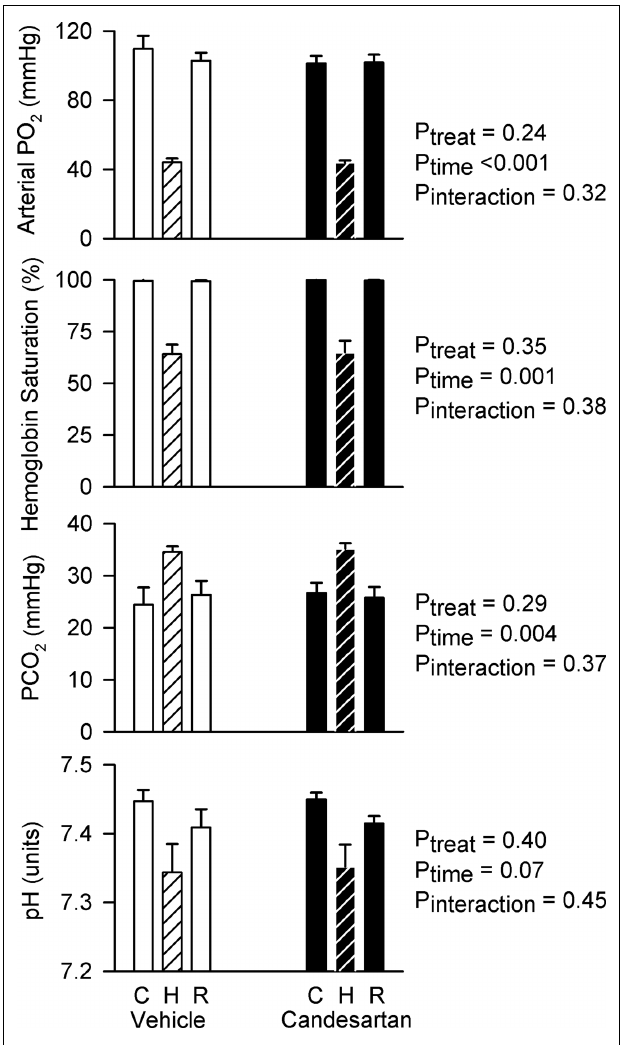
FIGURE 1 |Arterial blood gases before, during and after hypoxia in conscious rabbits treated with candesartan or its vehicle. PO 2 , the partial pressure of oxygen; PCO 2 , the partial pressure of carbon dioxide; C, control; H, hypoxia; R, recovery. P values represent the outcomes of two-way repeated measures analysis of variance, indicating significant changes in arterial PO 2 , hemoglobin saturation, and PCO 2 in response to hypoxia.